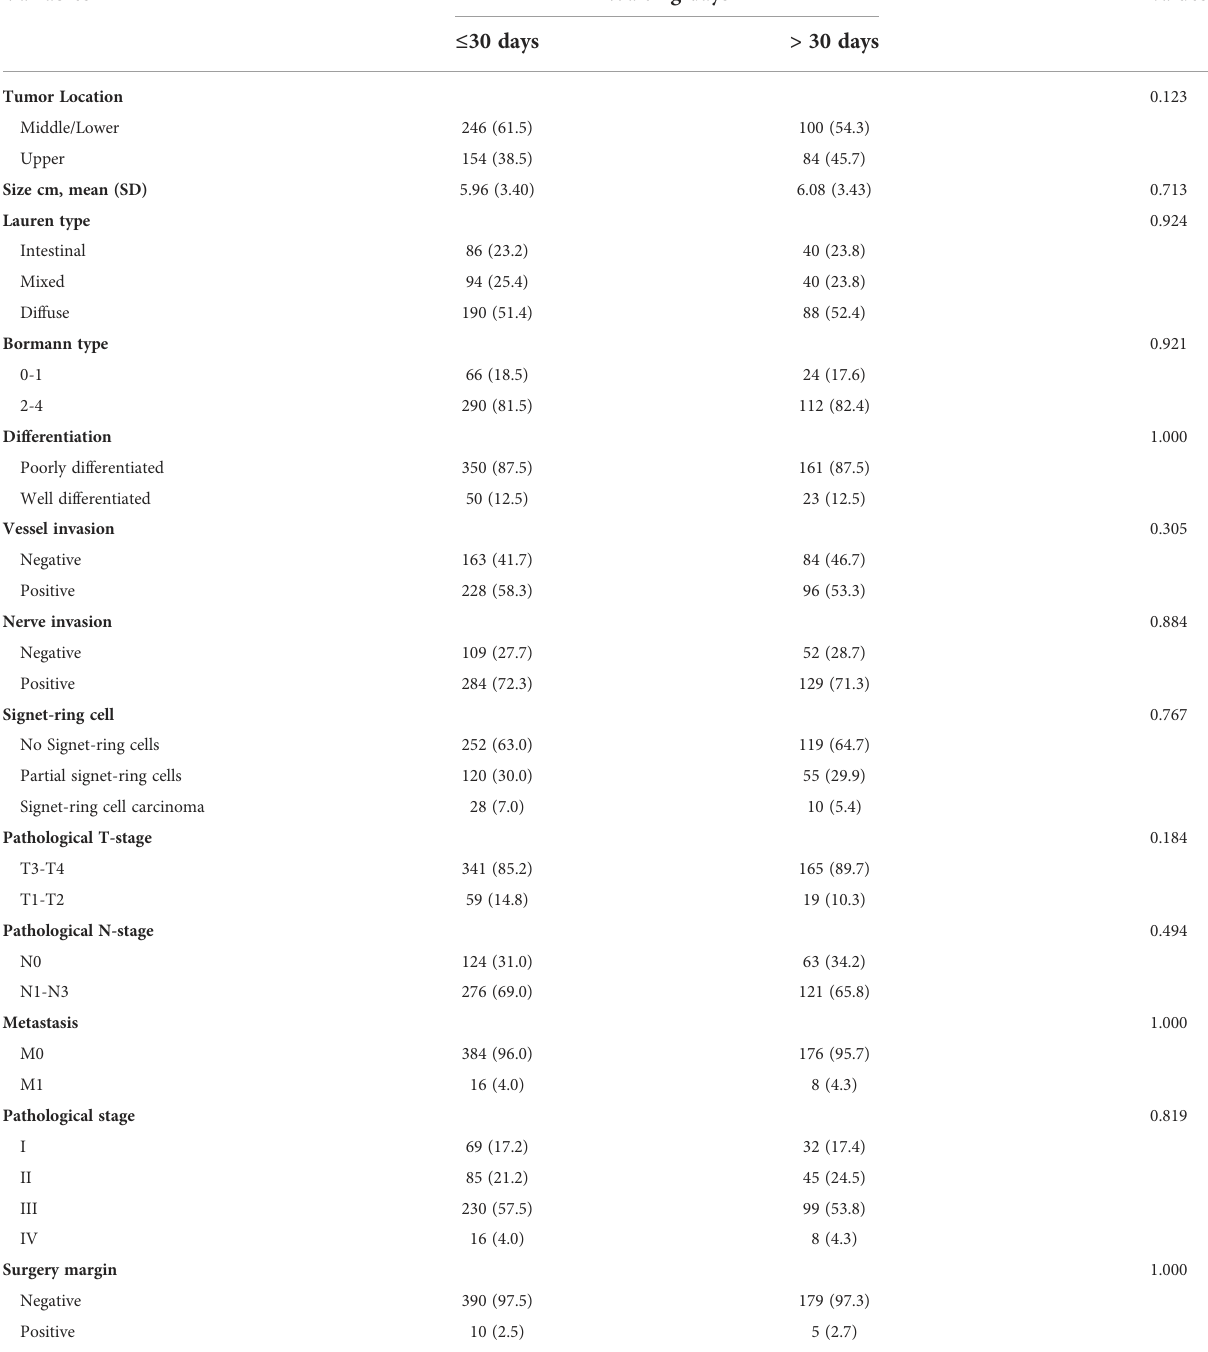
TABLE 3 Pathological characteristics of patients according to the waiting time for total